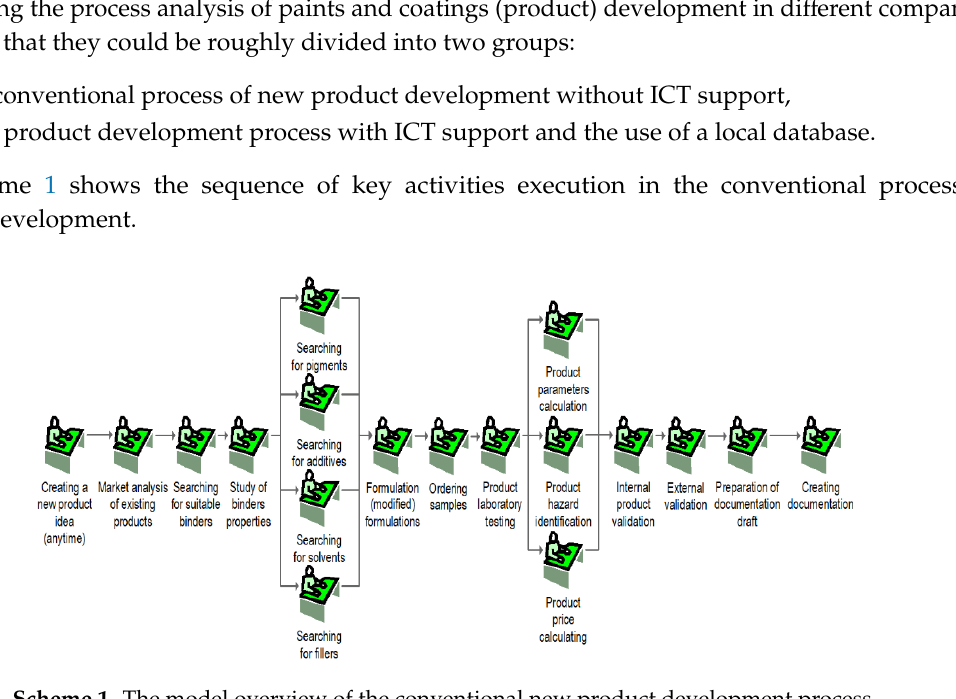
Table 1. Key activities of the conventional new product development process.